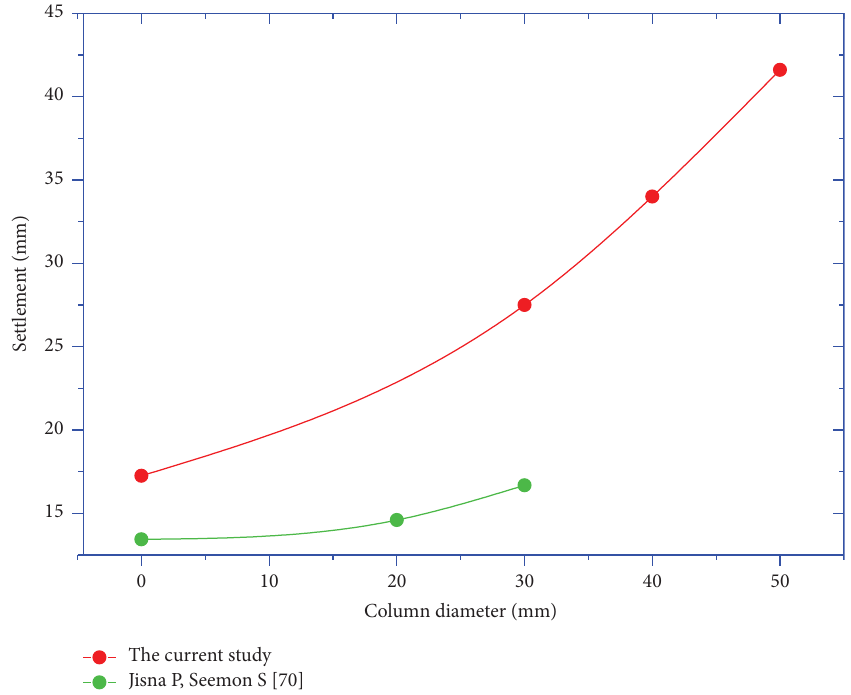
Figure 20: Comparison of settlement fnding of the study with Jisna and Seemon [71]. Table 5: Comparison of fndings of the current work with existing literature for applied stress of